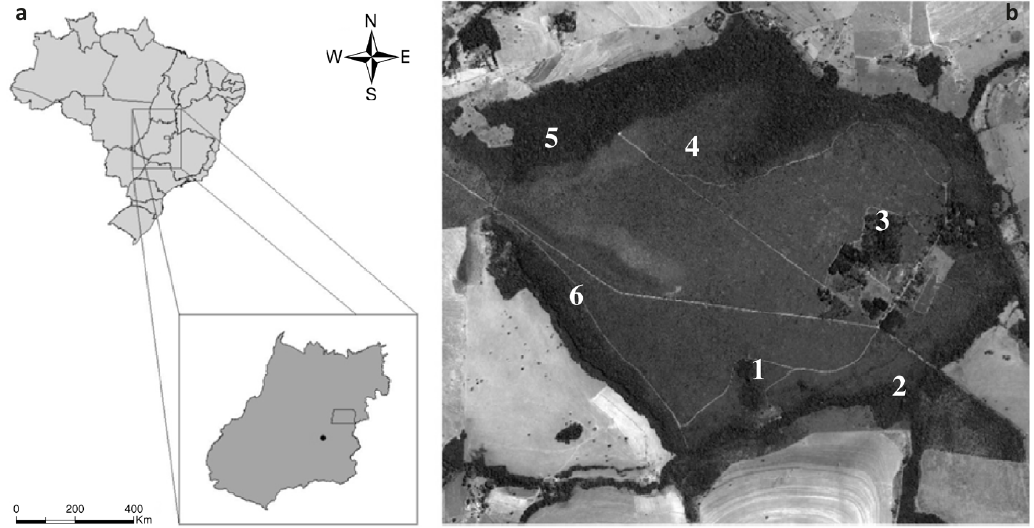
Figure 1. (a) Location of the municipality of Silvânia in the state of Goiás, Central Brazil. (b) Aerial view of the National Forest of Silvânia (Source: Erdas Viewfinder). The Cerrado “sensu stricto” areas were represented by the numbers 1 and 4, the gallery forest areas by the numbers 2 and 5, the anthropogenic environments by the number 3 and the transition areas between Cerrado “sensu stricto” and Gallery forest by the number 6.